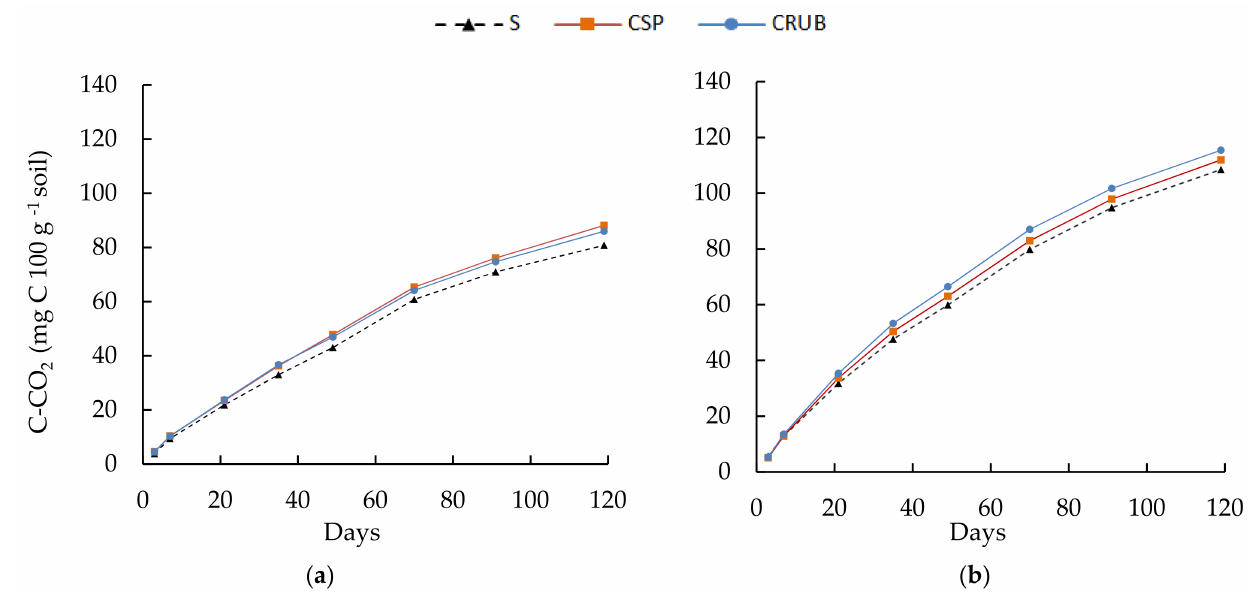
Figure 5. Cumulative mineralization of C-CO 2 . ( a ): S1; ( b ): S2. S: control. CSP: poultry manure and wheat straw; CRUB: biosolids and wood shavings.